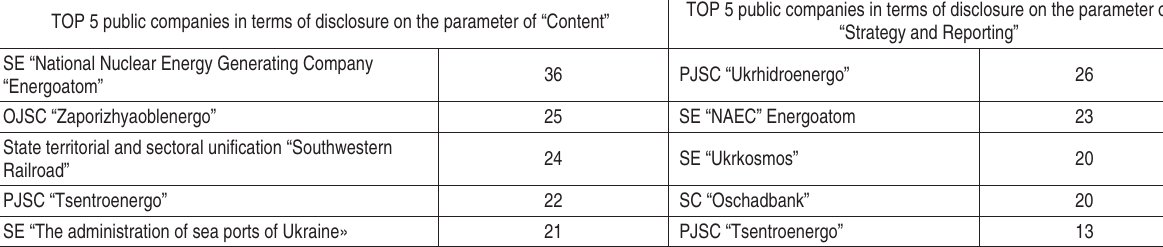
Table 2. Transparency index of Top 5 Ukrainian public companies by the methodology of the Center “CSR Development”